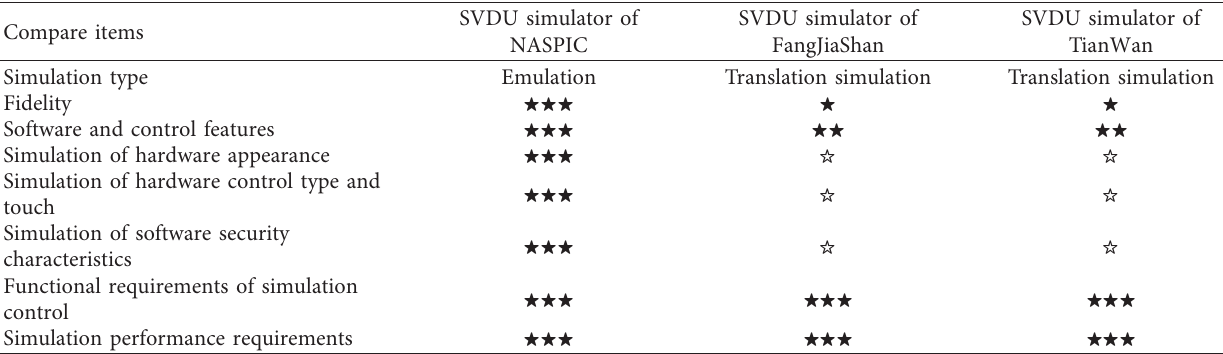
Table 2: Comparison results of SVDU